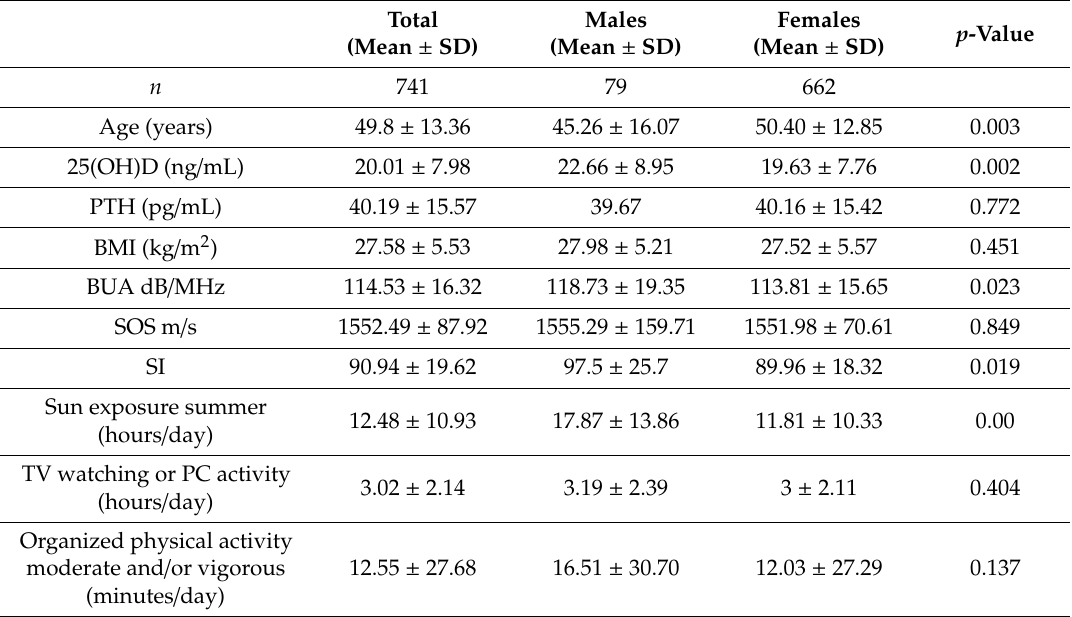
Table1. Descriptivecharacteristics.PTH:parathyroidhormone; BMI:bodymassindex; BUA:broadband ultrasound attenuation; SOS: speed of sound; SI: sti ff ness